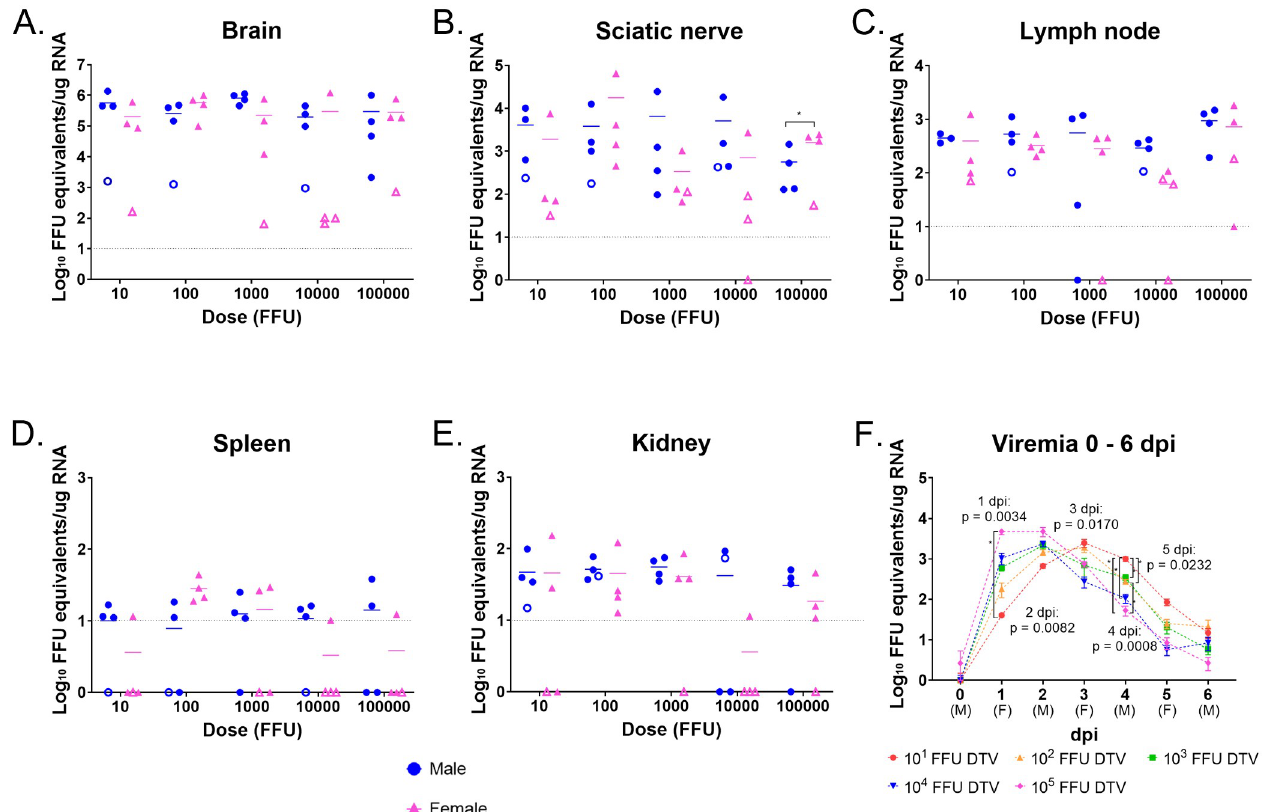
Fig 4. Detection of DTV in organs. A–E ) Organs were harvested at the time of euthanasia and viral loads were analyzed via q-RT-PCR. Viral load data are expressed as FFU equivalents per microgram of RNA after normalization to a standard curve. DTV titers are plotted for each mouse tissue, and horizontal bars indicate mean values for the group. Solid symbols represent mice that succumbed to disease, while open symbols represent mice that survived until the end of the study. Statistical significance between male and female titers was determined by an unpaired two-tailed t-test. � = p < 0.05. F ) Male and female mice were retro-orbitally bled on alternating days and blood was analyzed for viral load via q-RT-PCR. Each symbol represents the mean viremia (n = 4), and error bars are SEM. P-values were calculated by Welch’s ANOVA. Asterisk indicates the pair that shows significant difference with Dunnett’s T3 post-hoc